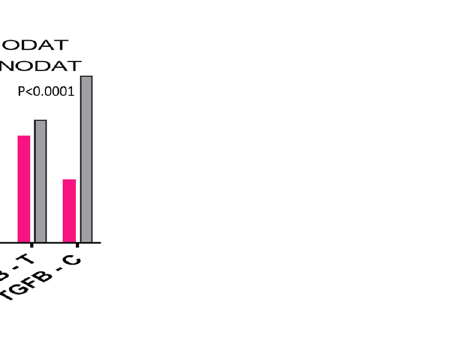
Figure 1. Genotypic frequencies of cytokines in NODAT and controls. Genotypes of cytokines are illustrated as homozygote (corresponded to high protein producer), heterozygote (corresponded to intermediate protein producer) and homozygote (corresponded to low protein producer). IL-6, IFNG and TGFB high producer genotypes were strongly associated with the disease, p = 0.05, 0.01 and 0.007; while, IL-4 high producer corresponded genotype was strongly associated with control cases, p = 0.001. In all cytokines intermediate protein level genotype did not show any significant association. Low protein producer corresponded genotypes were strongly associated with control group in IL-6, IFNG and TGFB, p = 0.05, 0.003 and 0.002; while, low protein level corresponded genotype in IL-4 was significantly associated with the disease, p = 0.001.